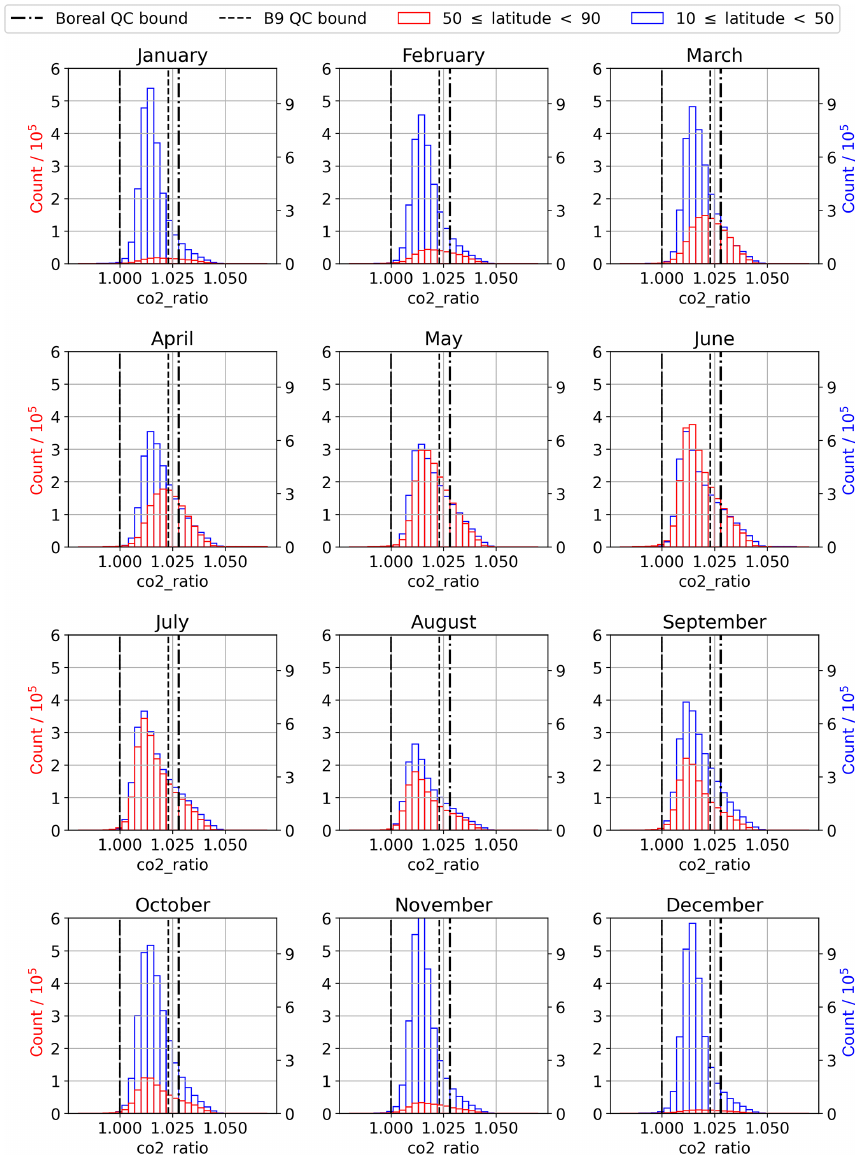
Figure 18. Monthly histograms of the ratio in single-band retrievals of CO 2 (co2_ratio) for all unfiltered OCO-2 retrievals over land (land_fraction=100) split into two latitude bands, namely 10 to 50 ◦ N and 50 to 90 ◦